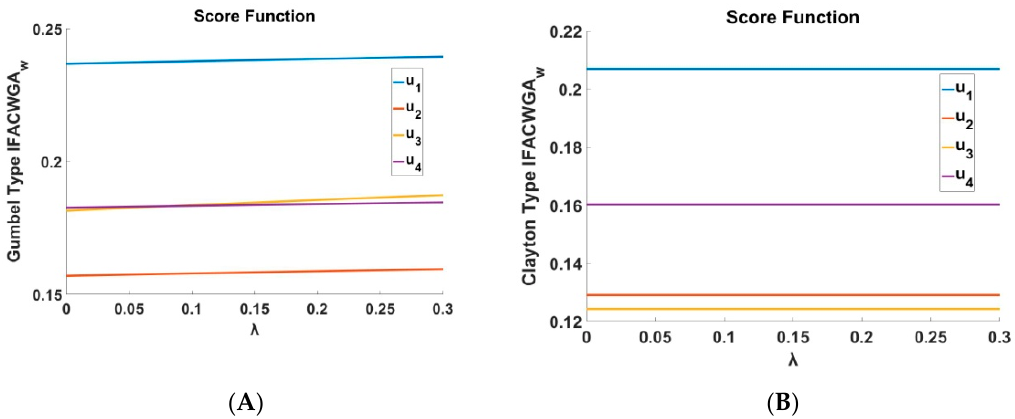
Figure 3. ( A ) Gumbel-type IFACWGA w score result. ( B ) Clayton-type IFACWGA w score result.